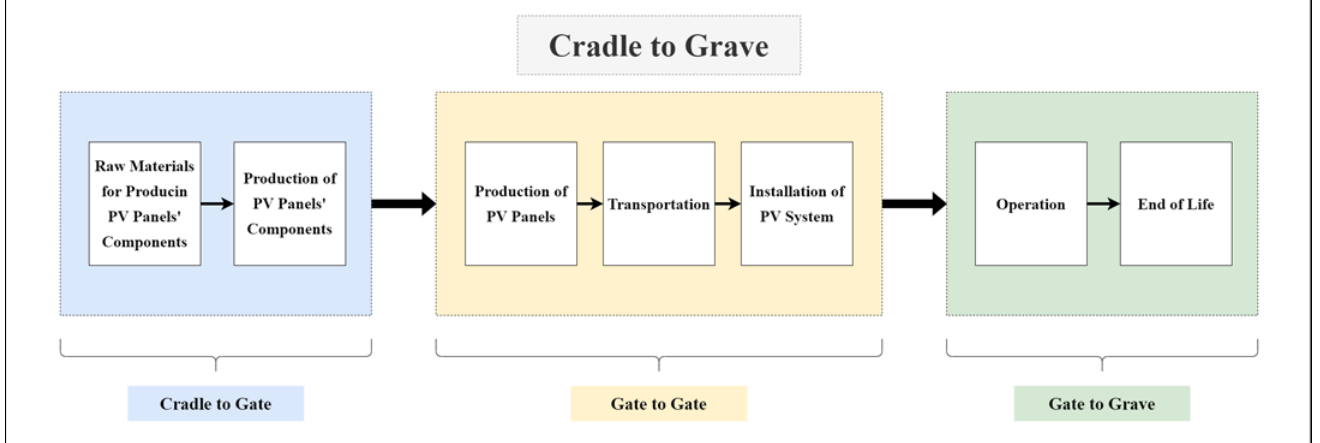
Figure 3. System boundary — LCA for a PV project in the UAE .